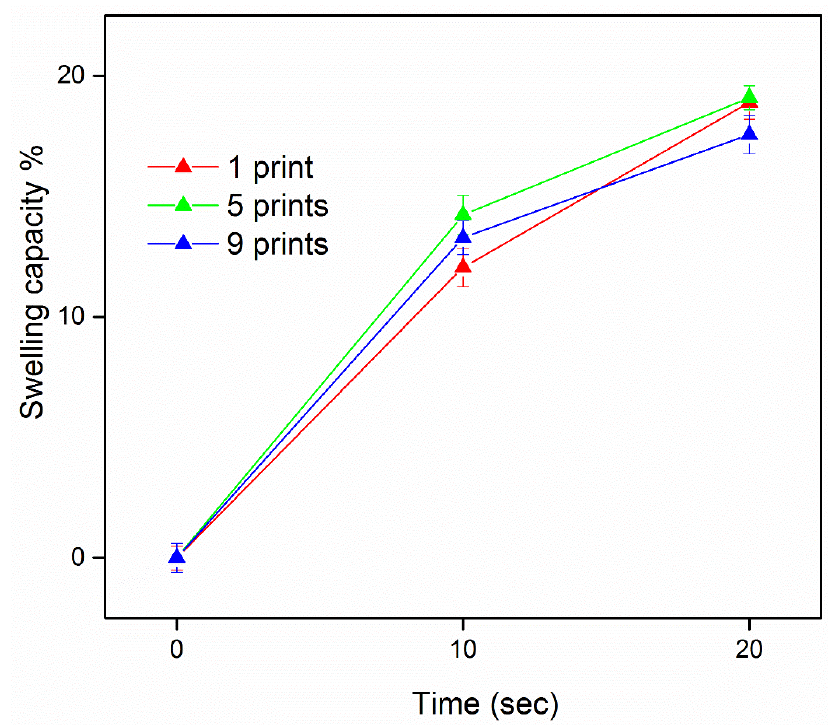
Figure 1. The water uptake capacity of films with a varying number of consecutive prints.